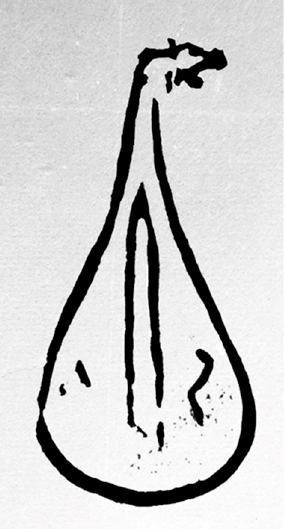
Figure 18. A Song Yuan Huaya in the shape of Hu Pipa with crooked neck. The period of the Song and Yuan Dynasties. Inventory number: 1883. Sketched by author. Picture source: Wen (1995), p. 439. The original collection: Cheng, Conglong. Chenglijiang Yinpu [ 《程荔江印譜》 ]. Book of impressions. 1927.